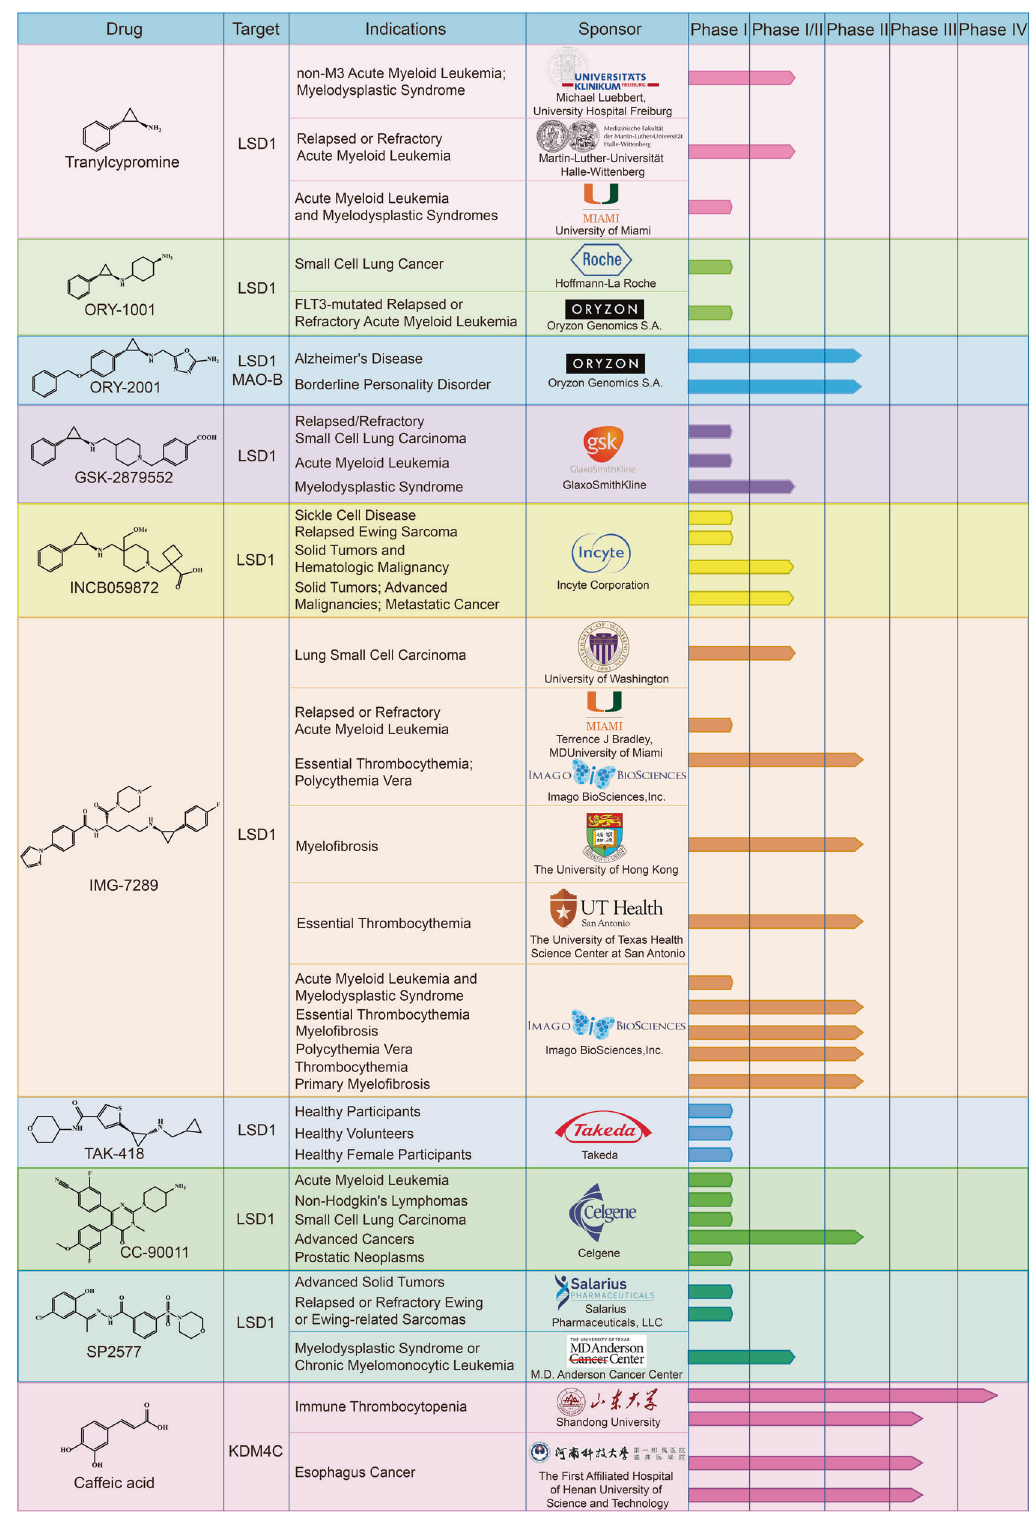
Fig. 7 Representative inhibitors against histone demethylases in clinical trials